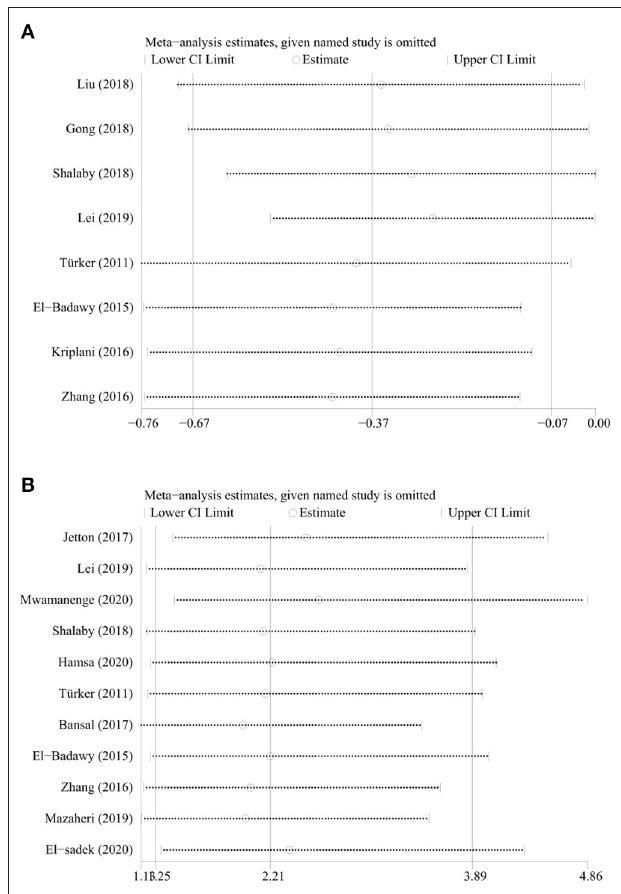
FIGURE 3 | (A) Sensitivity analysis for birthweight; (B) sensitivity analysis for sepsis.